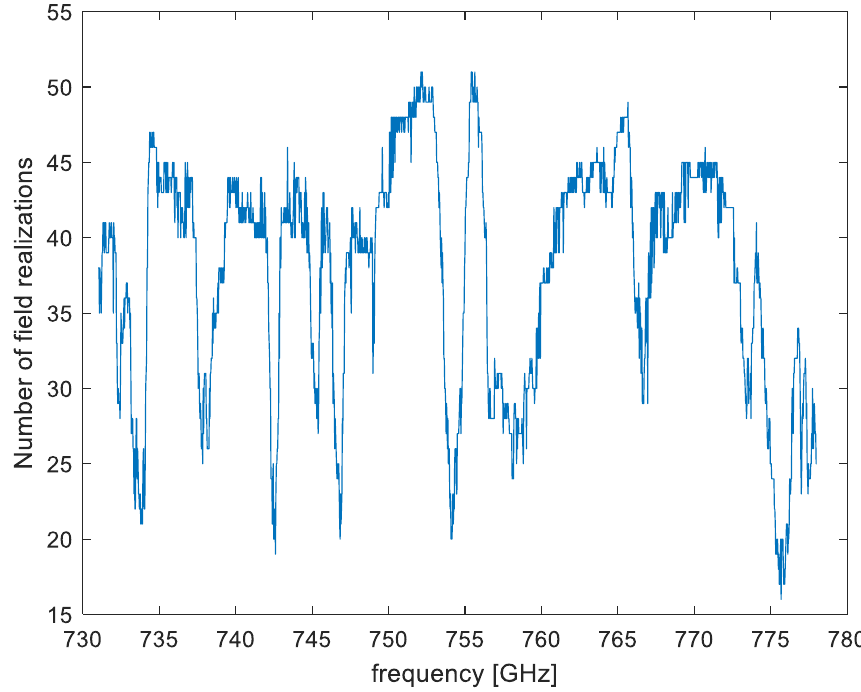
Figure 9. Number of field realizations selected by the algorithm in the frequency band 711 – 778 MHz.